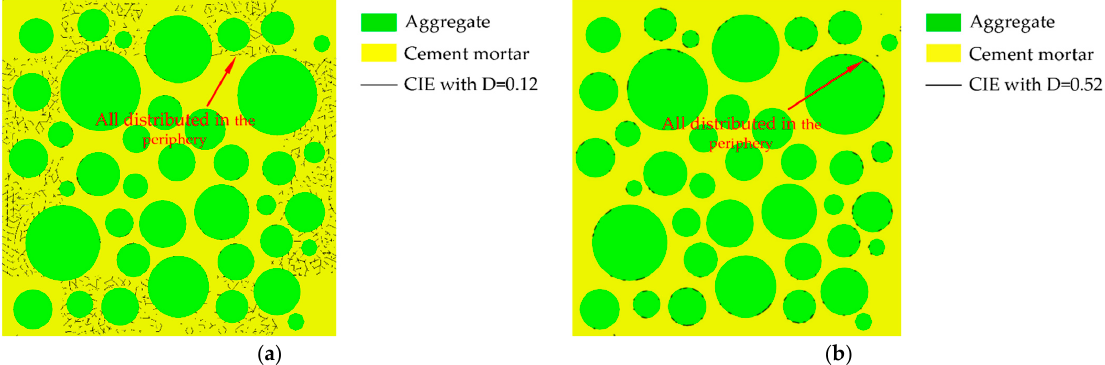
Figure 6. The distribution of the CIEs with D = 0.12 and D = 0.52 when σ / σ max ≈ 0.36. ( a ) D = 0.12; ( b ) D = 0.52. 2. The stable development stage of cracks (0.3~0.5 < σ / σ max < 0.75~0.9); and D = 0.7 when σ / σ max ≈ 0.74, which show that, at this stage, with the increase of stress,